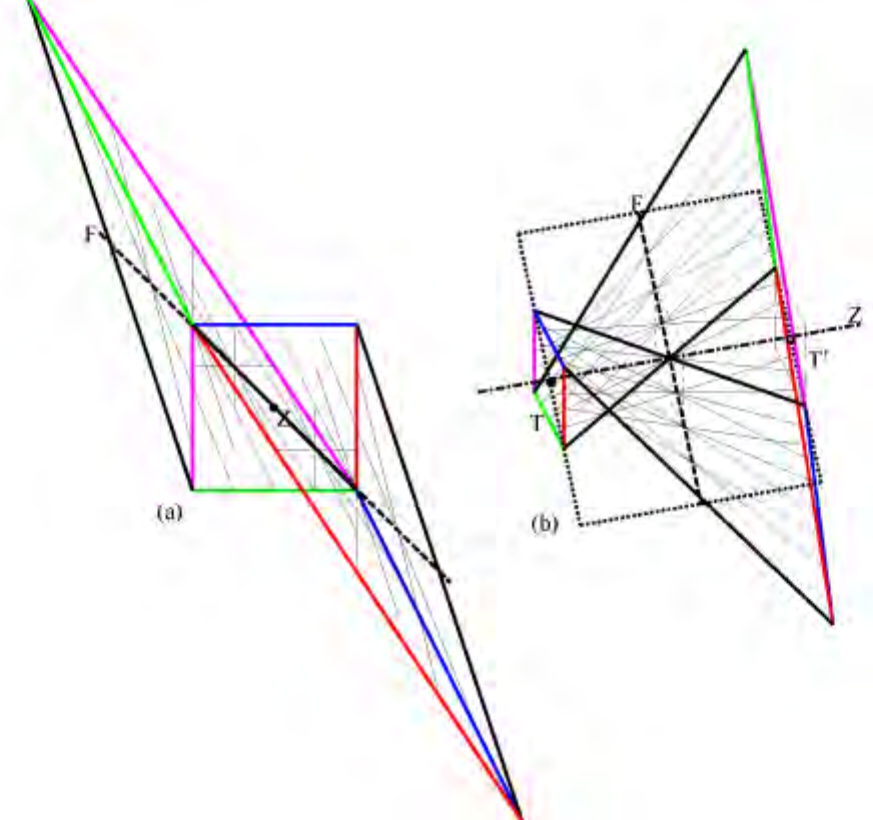
Figure 20 A pencil with divergency LJIM ++−= D at T. The two principal planes of Figures 16 to 19 have merged to become one at . There is a unique focal line at the same angle. (b) azimuth °− 20 17 °− 20 , elevation 36 °− 20 .